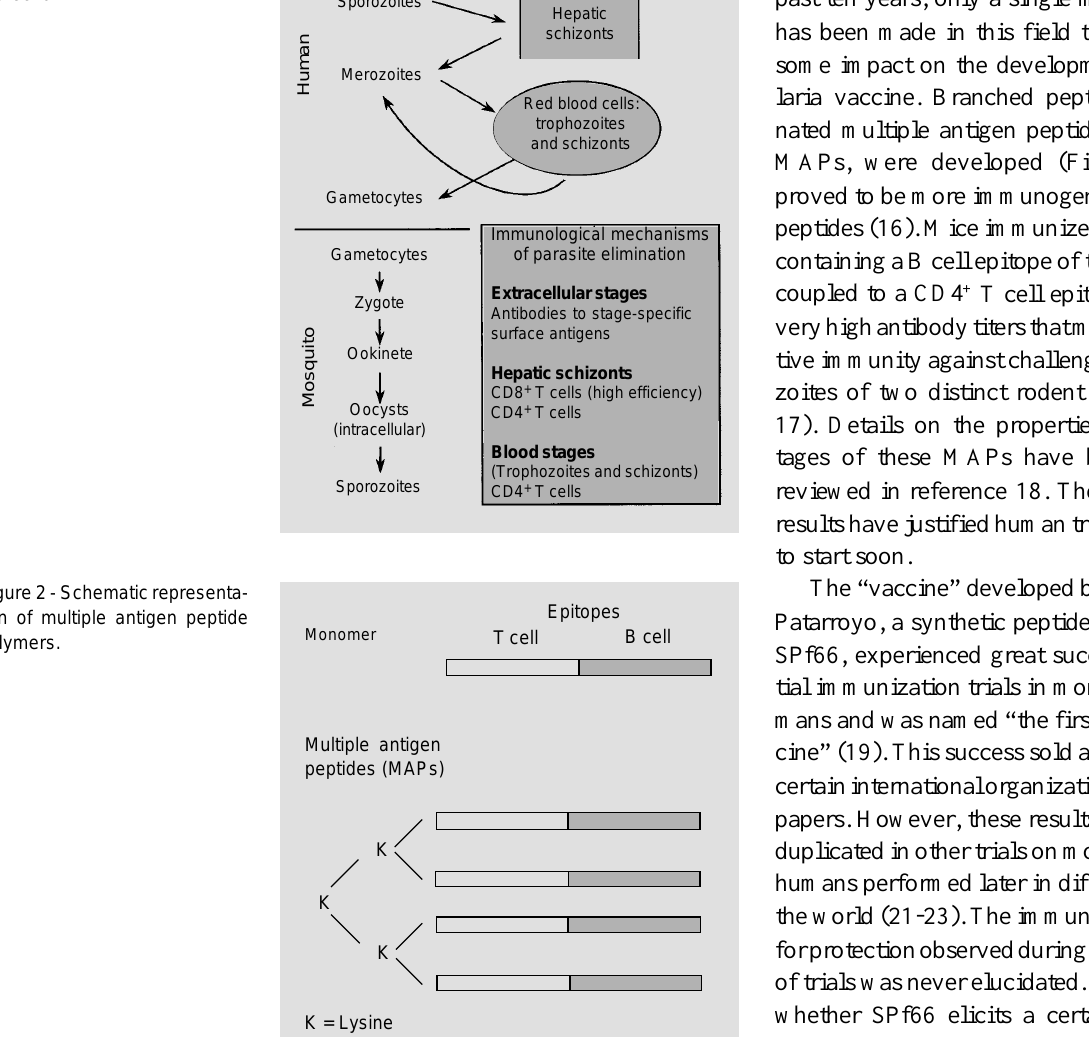
Figure 1 - Schematic representa- tion of the life cycle of malaria parasites and description of host immunological mechanisms of protection.